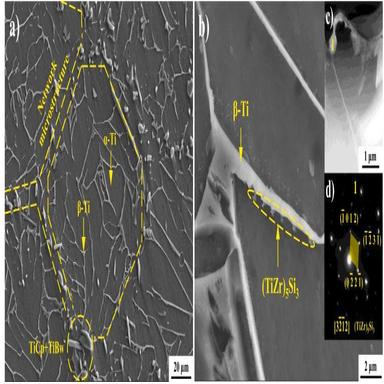
Microstructure of the as-sintered (TiC+TiB+(TiZr)5Si3)/TA15 composites: (a) SEM-SE micrograph, (b) high magnification SEM-SE micrograph, (c) TEM-BF image of silicides, (d) SAD patterns of point 1 (the silicide) in (c).